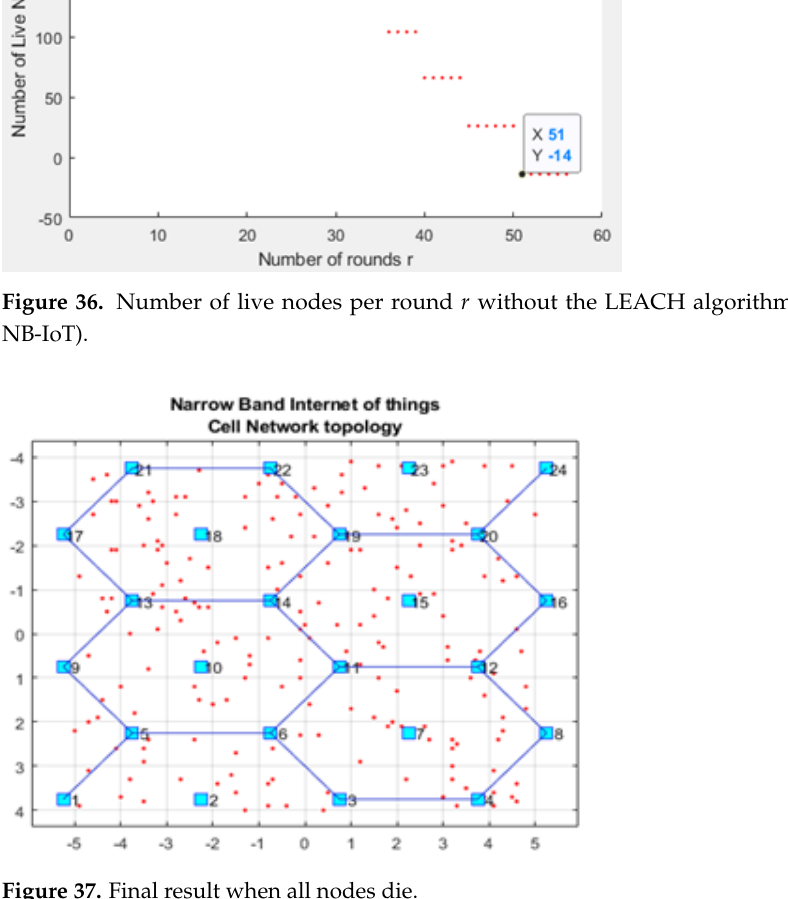
Figure 37. Final result when all nodes